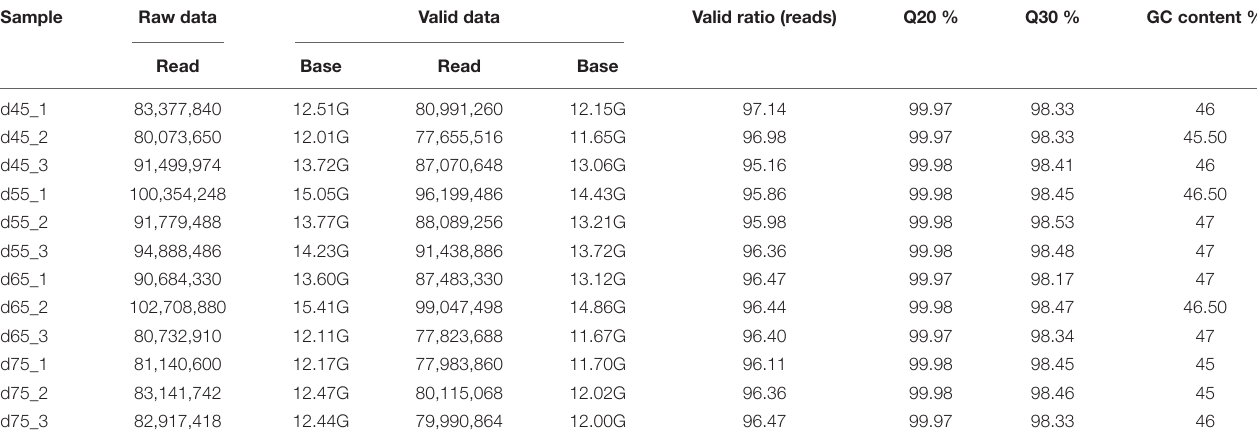
TABLE 1 | Data quality control statistics.